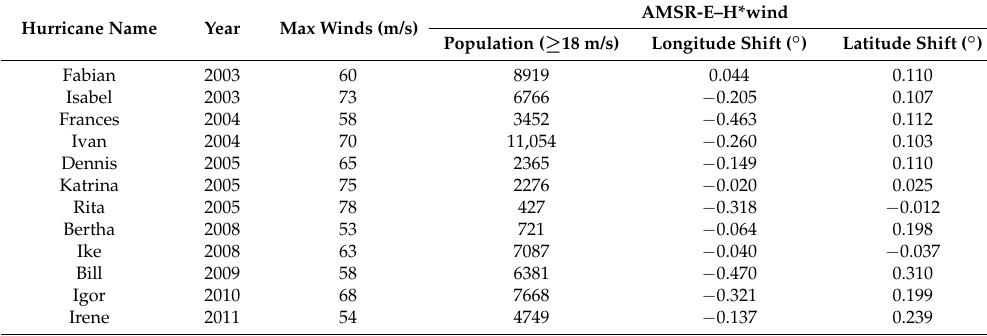
Table 1. Statistics of matchups between AMSR-E measurements and H*wind analysis data.